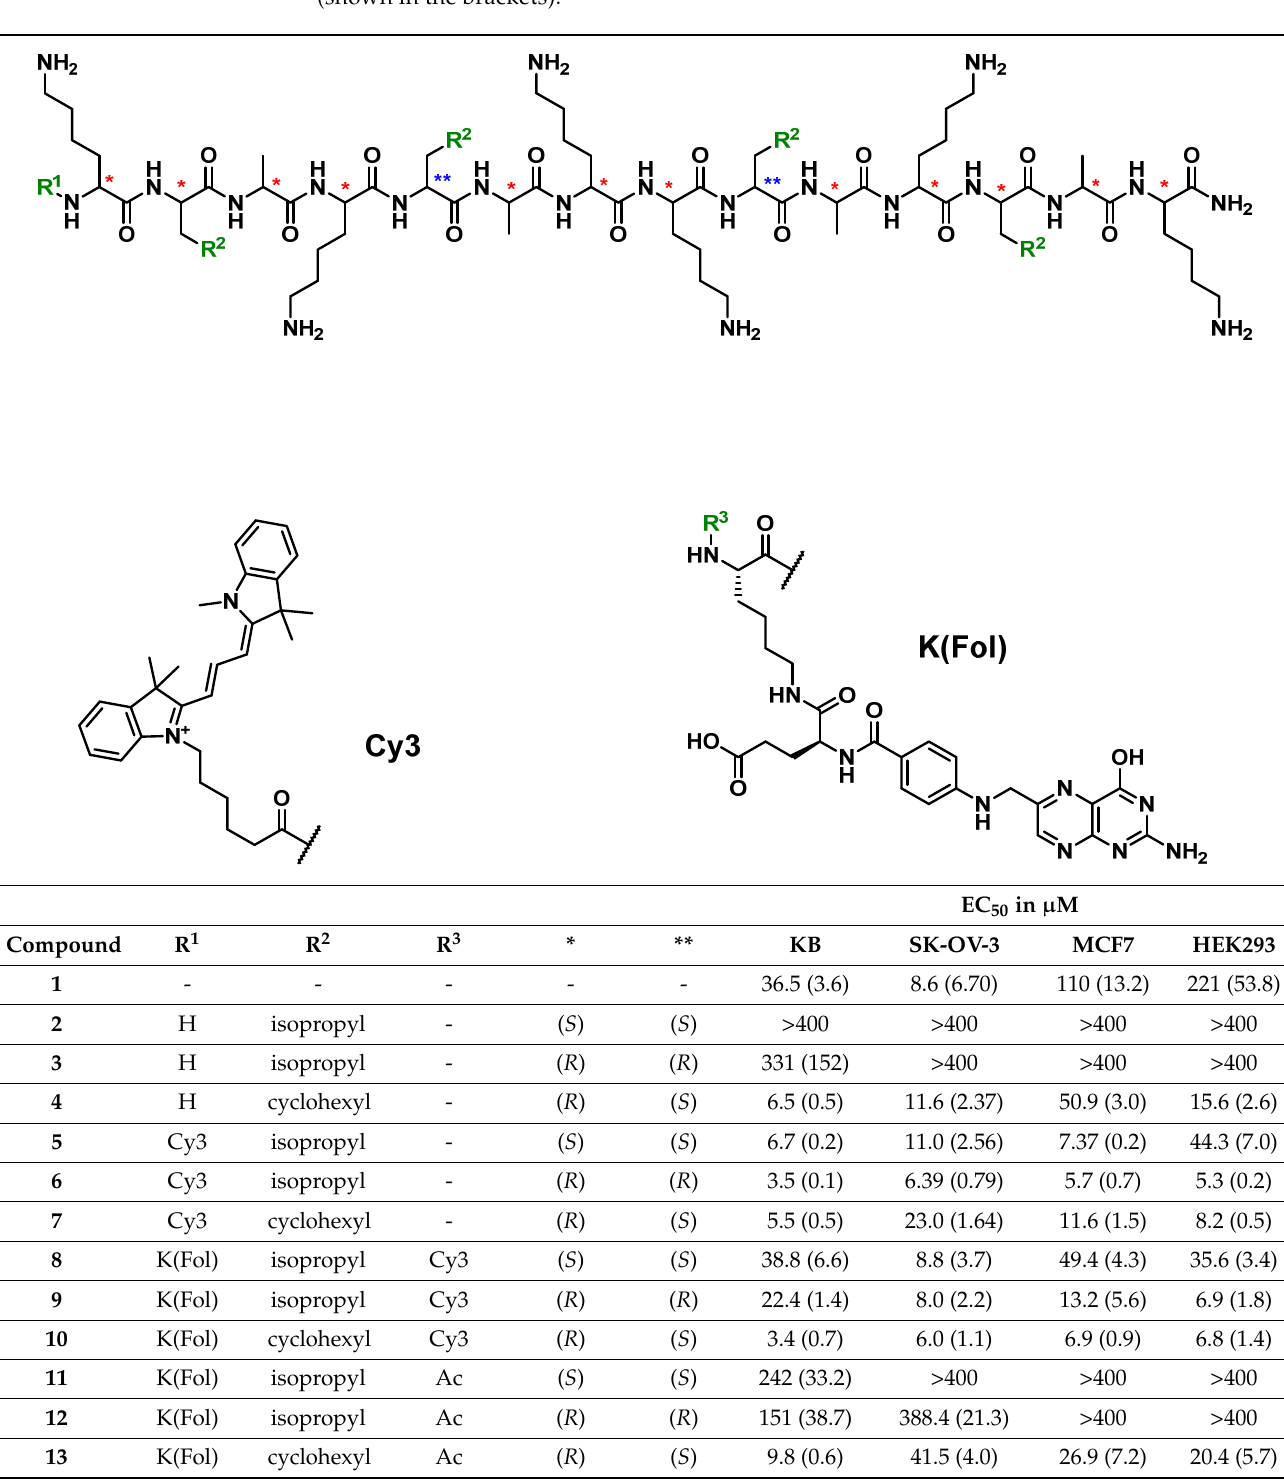
Table 1. Chemical structure of 2 – 13 and cytotoxicity values for compounds 1 – 13 . The EC 50 values (expressed in µM) on KB, SK-OV-3, MCF7 and HEK293 cells of different molecules and their cyanine dye conjugates were quantified using cell viability assays. Data from three biological replicates were combined and fitted using Origin to obtain the EC 50 values and the standard errors (shown in the brackets).